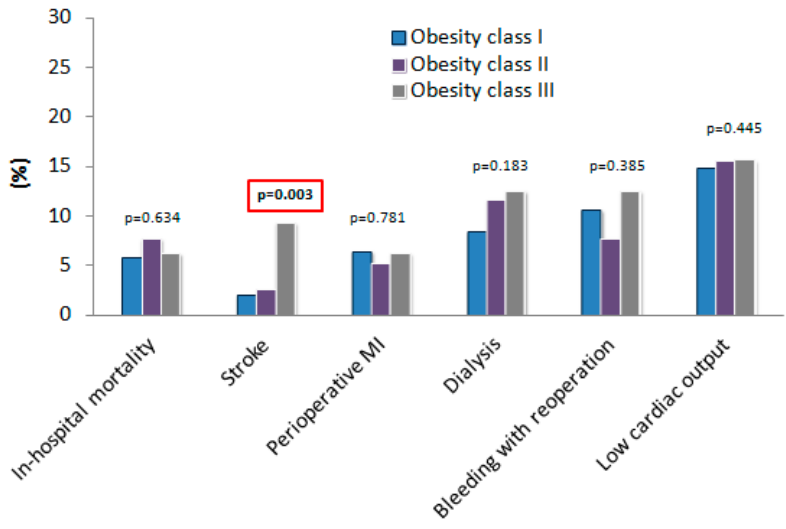
Figure 3. Primary and secondary outcomes by obesity classes (I, II, III) after CABG surgery in ACS after PSM.